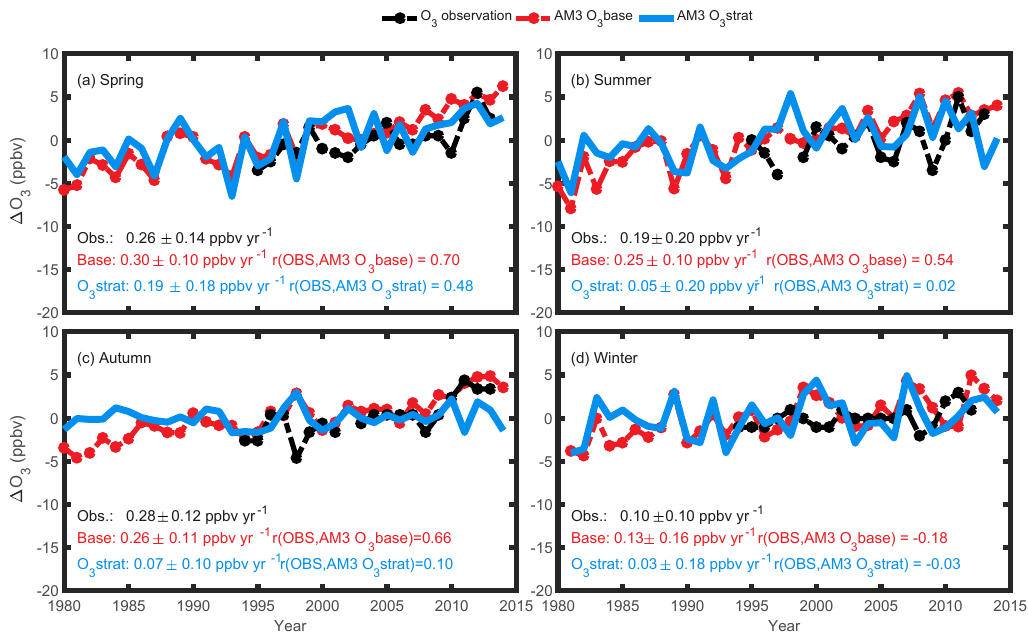
Figure 4. Comparison of seasonal median ozone anomalies at Mt Waliguan over the period of 1980–2014 from available observations (black), GFDL AM3 BASE simulations (red), and AM3 stratospheric ozone tracer (O 3 Strat, blue) for (a) spring, (b) summer, (c) autumn, and (d) winter. The linear trends (with the 95% confidence intervals) over the period of 1994–2013 and correlations between observations and models are shown.